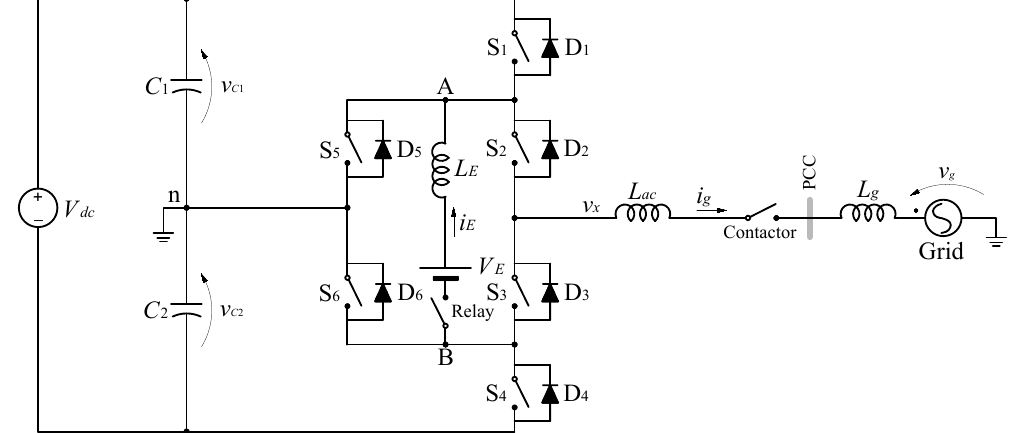
Figure 3. Three-Ports Active Neutral- Point-Clamped (ANPC-3P) topology in a grid-tied